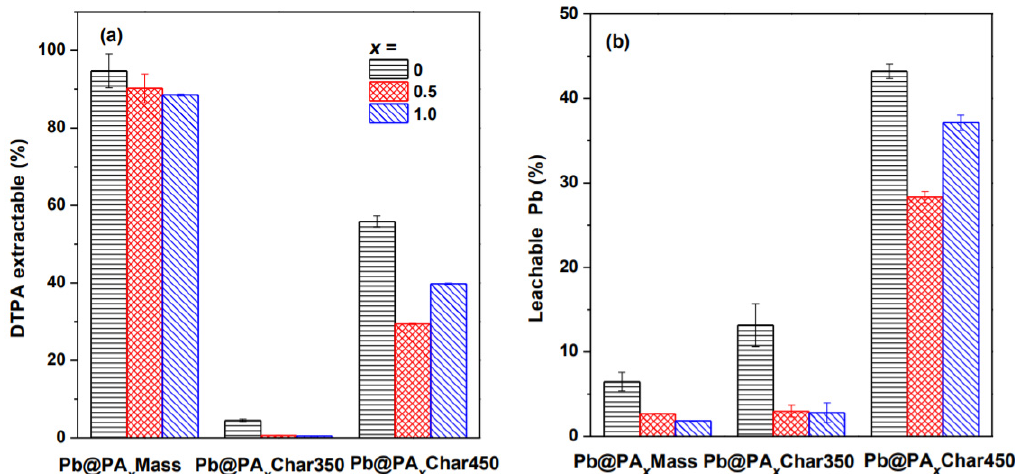
Figure 5. ( a ) DTPA-extractable Pb from, and ( b ) TCLP-leachable Pb from the biomass samples pretreated with various dosages of PA (0, 0.5, and 1.0 g/g mass) and the corresponding chars obtained at different pyrolysis temperatures (350 or 450 °C).